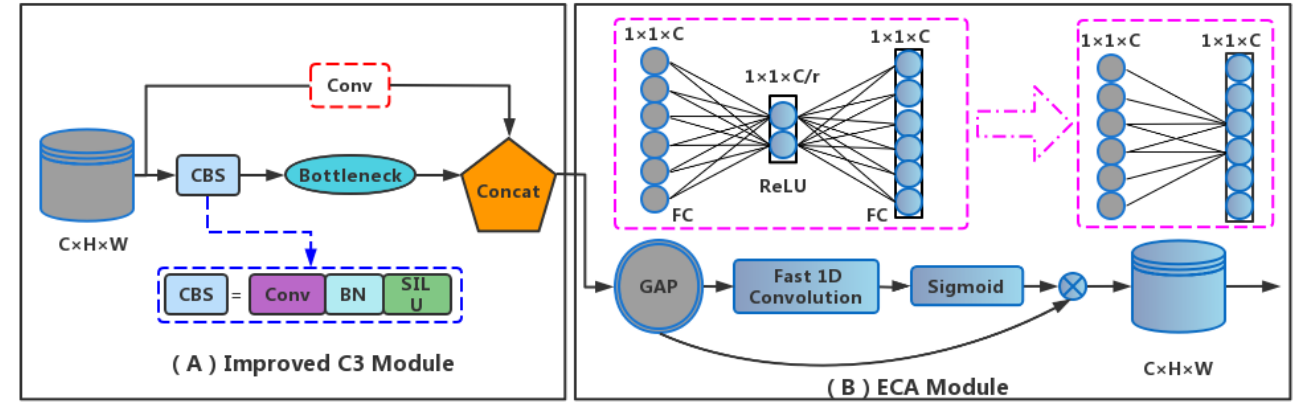
Figure 2. The structure of improved C3 module and ECA (Efficient Channel Attention) module. C , H , and W refer to the channels, height, and width of the input image. Conv means that the convolutional layer ( A ) The red dotted box indicates that the convolution layer has been removed. The blue